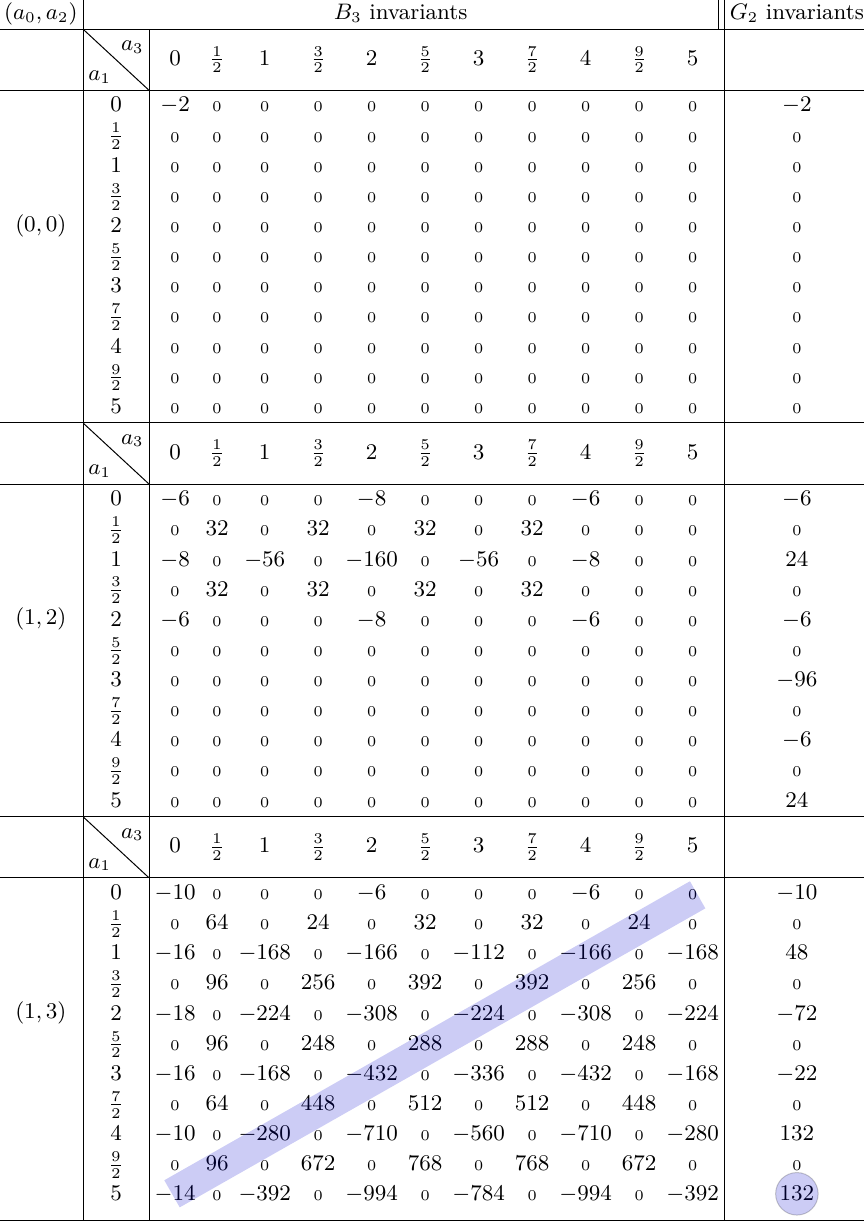
Table 5 . Genus 0 Gromov-Witten invariants of B 3 and G 2 over F 2 . Adding the entries in the diagonals given by a with equation (3.29). For example, the sum of the B invariant in the blue